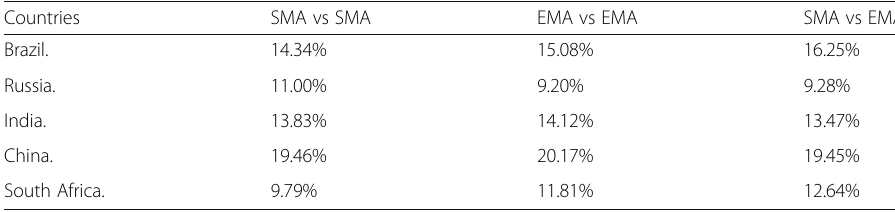
Table 4 Percentage of better results than the buy and hold